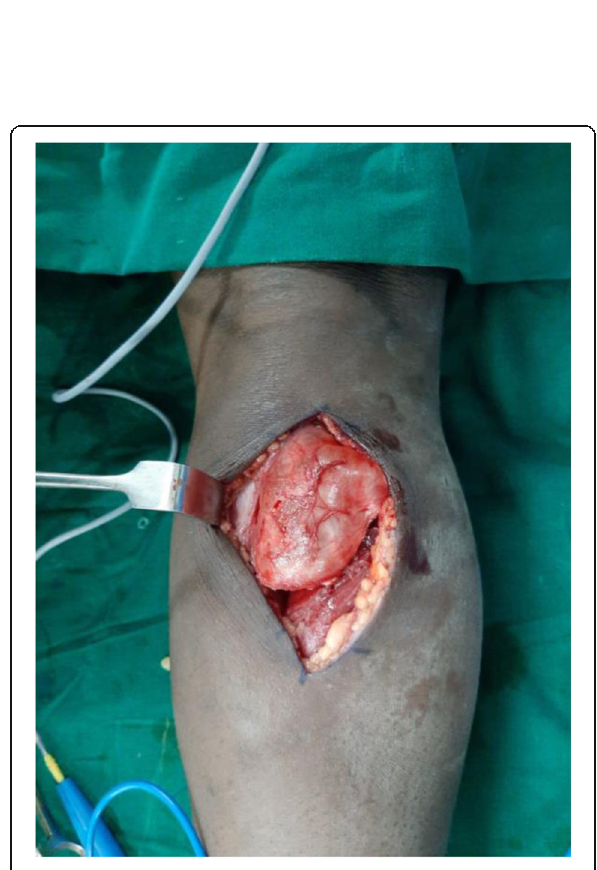
Fig. 5 Intraoperative image showing a pearly white well- encapsulated cystic lesion in the intermuscular plane. The lesion was separated from the neurovascular bundle and had no continuity with the